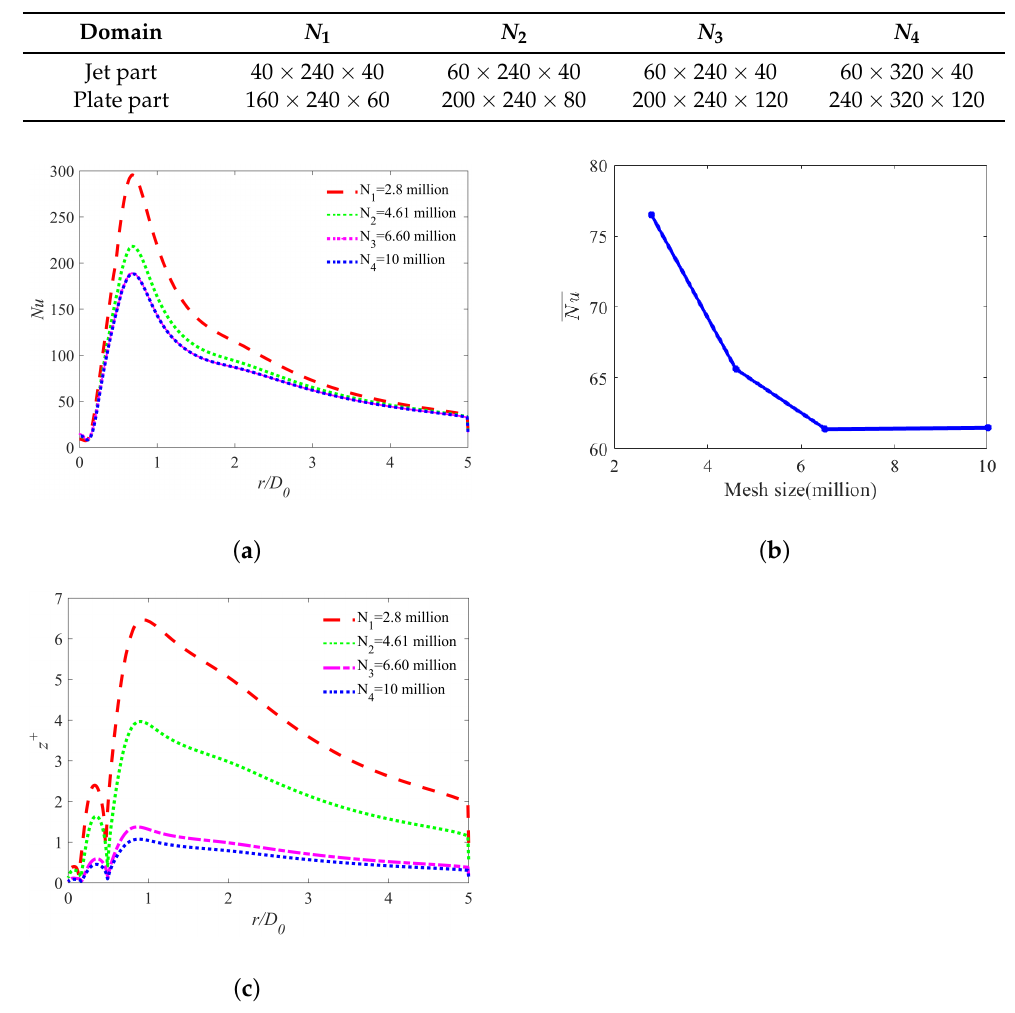
Figure 6. Mesh sensitivity check using ( a ) Radial Nusselt number. ( b ) Convergence of the average Nusselt number. ( c ) Radial z + on the impingement